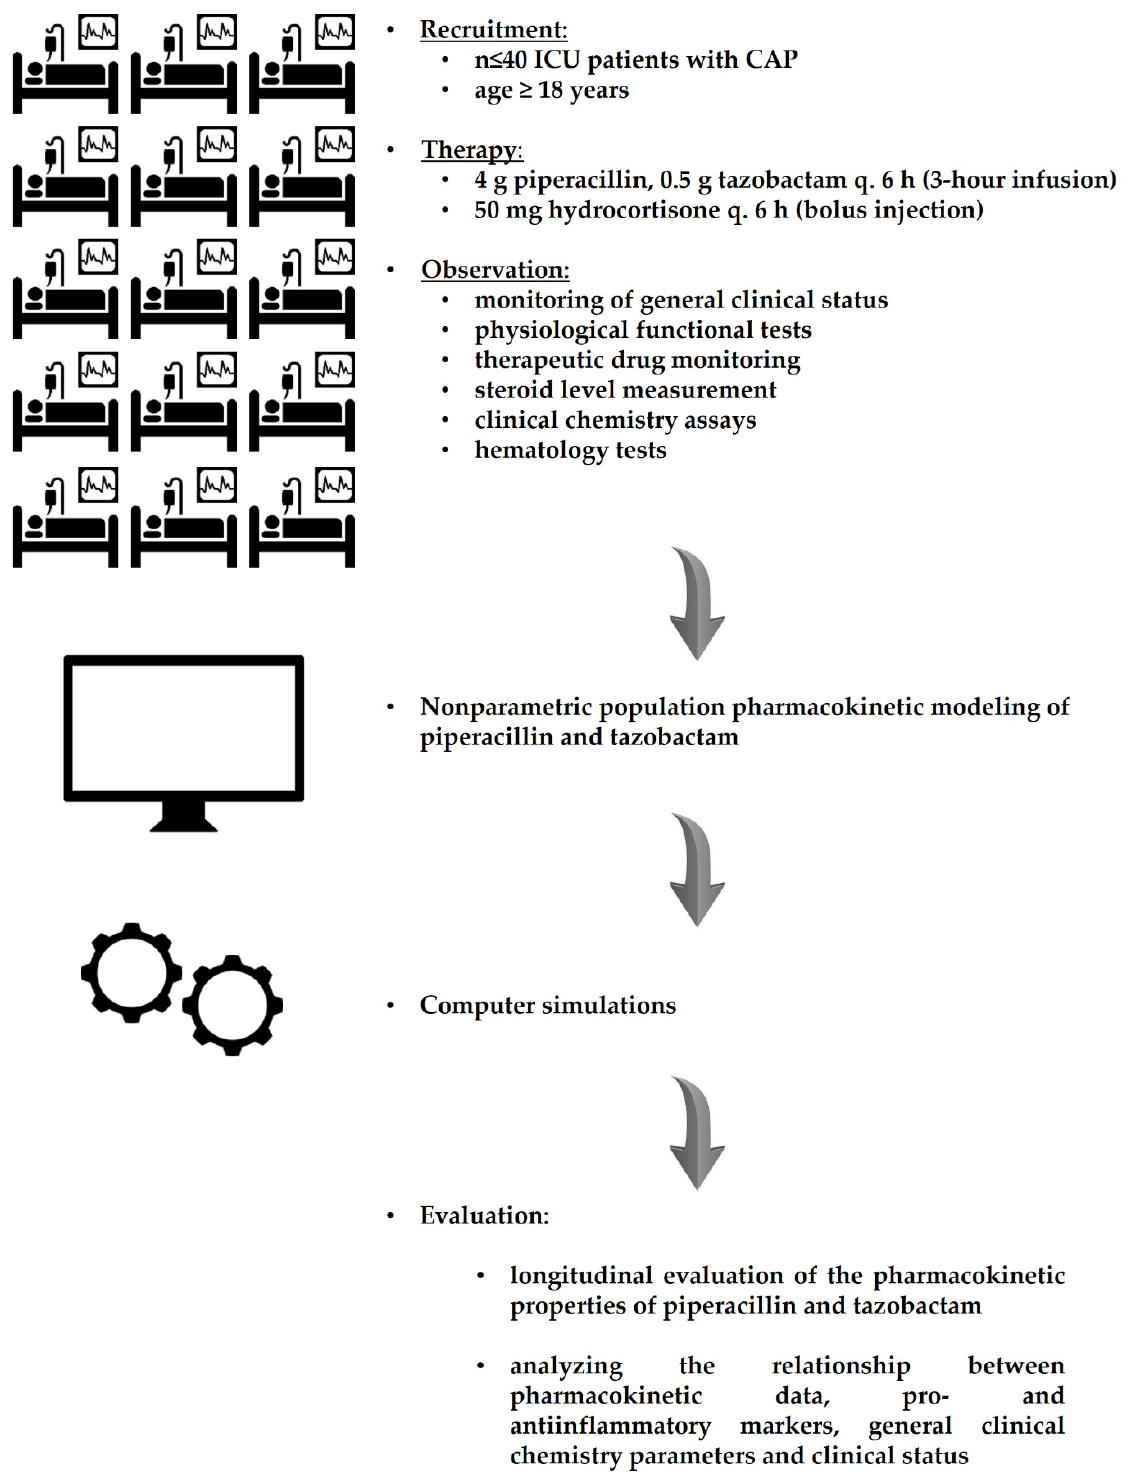
Figure 1. Overview of the study